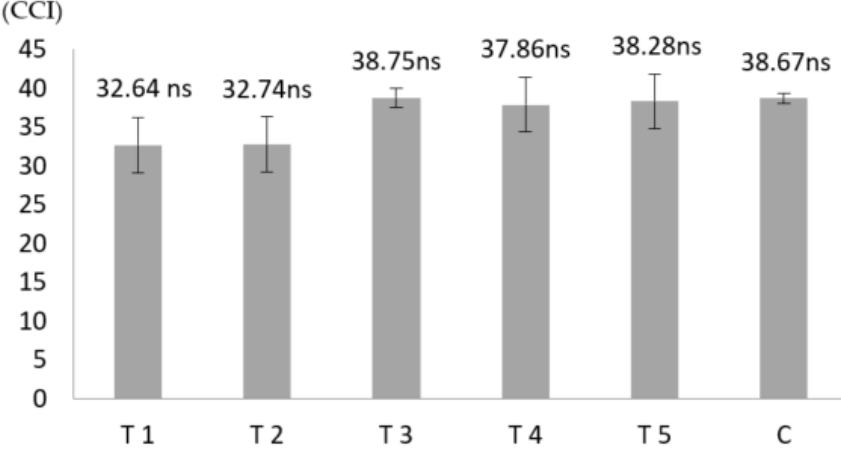
Figure 2. Chlorophyll content index from tomato plant (T1—0.15 A; T2—0.30 A; T3—0.45 A; T4— polarity; T5—soil version; C—Control; ns-nonsignificant).